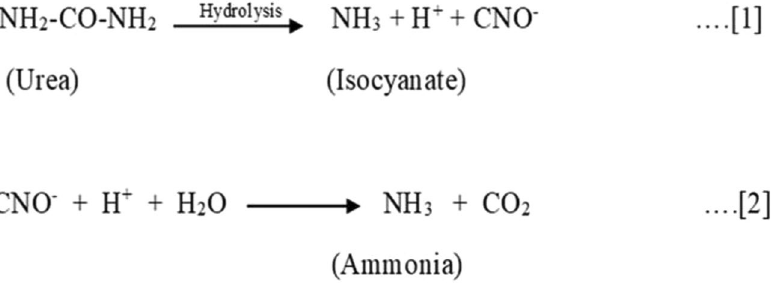
Figure 1. Conversion of urea to ammonia by